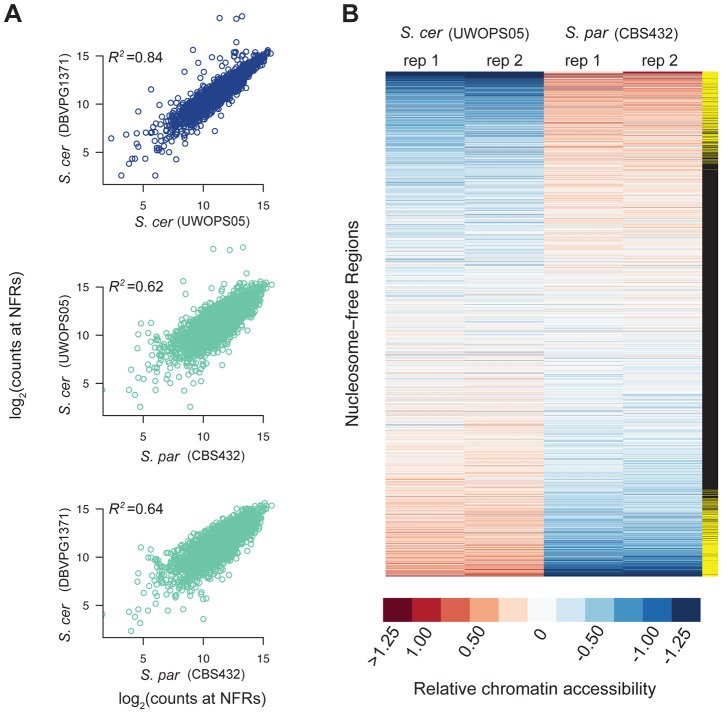
Patterns of chromatin accessibility within and between S. cerevisiae and S. paradoxus.A. Scatterplots of relative chromatin accessibility between S. cerevisiae strains DBVPG1373 and UWOPS05_217_3 (top), S. cerevisiae strain UWOPS05_217_3 and S. paradoxus strain CBS432 (middle), and S. cerevisiae strain DBVPG1373 and S. paradoxus strain CBS432 (bottom). Note, comparisons within and between species are shown as blue and light green, respectively. B. Heatmap representation of chromatin accessibility at all NFRs in S. cerevisiae strain UWOPS05_217_3 versus S. paradoxus strain CBS432. Each row is a NFR, and columns are the two biological replicates of S. cerevisiae strain UWOPS05_217_3 and S. paradoxus strain CBS432. Rows are sorted by average difference in signal at NFRs between S. cerevisiae and S. paradoxus. The far right column indicates if the difference in chromatin accessibility between species is significant (yellow rectangles).